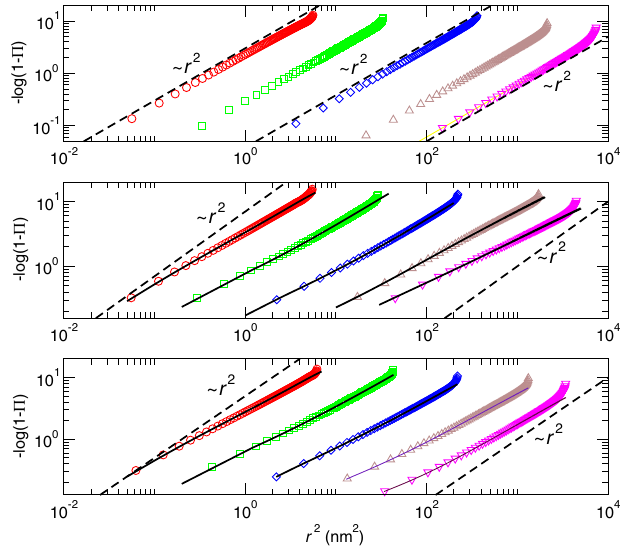
FIG. 3. Cumulative distribution Π ð r 2 ; Δ Þ for squared displace- ments r 2 ¼ ½ r ð t þ Δ Þ − r ð t Þ(cid:2) 2 of individual lipids. The value − log ½ 1 − Π ð r 2 ; Δ Þ(cid:2) is plotted against r 2 at lag times Δ ¼ 1 ns (red), 10 ns (green), 100 ns (blue), 1000 ns (brown), and 5000 ns (magenta), from left to right. For a Gaussian process the scaling of − log ð 1 − Π Þ ∼ r 2 is obtained [94] as indicated with dashed lines in the plot. Data are for the noncrowded DPPC (top), aggregating protein-crowded DPPC (middle), and nonaggregat- ing protein-crowded DLPC (bottom) systems. For the latter two cases the exponent deviates substantially from a value of 2, as seen from the Gaussian guide lines. The solid lines depict the theoretical curves [Eq. (5)] of − log ð 1 − Π Þ expected from the non-Gaussian propagator P fitting to the simulation data shown in Fig.